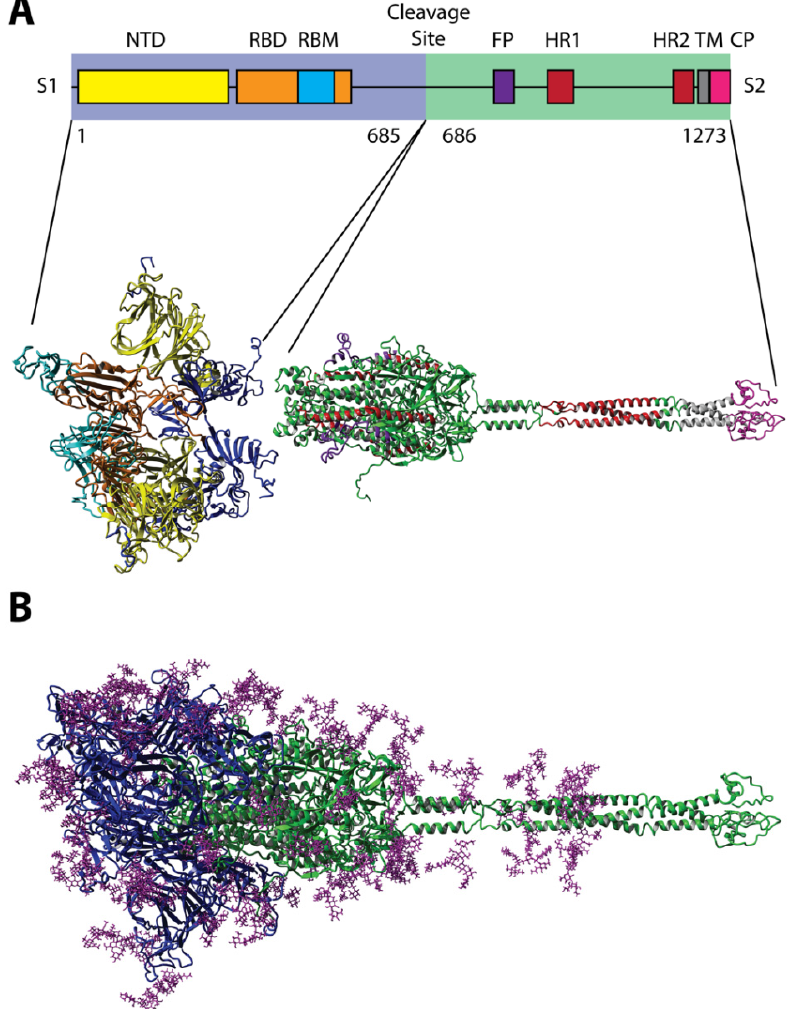
Figure 1. Three-dimensional predicted model of the spike (S) glycoprotein of the SARS-CoV-2 virus composed of ( A ) two well-defined structural domains (S1 and S2), decorated with ( B ) 22 N-glycan residues as modeled using 6VSB and 6VXX [38,39]. Monomers of the S protein, composed of polypeptide chains of 1273 amino acids, form homotrimer spikes on the virus surface [18]. Spike protein monomers are composed of three major structural domains: head, stalk, and cytoplasmic tail. The head comprises the N-terminal domain (NTD; yellow) and the receptor-binding domain (RBD; orange), which displays the receptor-binding motif (RBM; cyan) that is responsible for interaction with cell receptors [40]. RBDs in non-activated viral S glycoprotein trimers are present in a hidden “down” conformation. The S glycoprotein is cleaved by host proteases (trypsin and furin) at the site between the S1 and the S2 subunits [41,42]. The S2 domain of the S protein consists of fusion peptide (FP; purple), two heptad-repeat domains (HR1 and HR2; red), a transmembrane domain (TM; gray), and a cytoplasm domain (CP; pink). A second proteolytic site (S2 ′ site), located within the S2 subdomain, is also cut by type II transmembrane serine protease (TMPRSS2) as well as cathepsin B and L (CatB/L) to enable virus-cell fusion by triggering the dissociation of S1 and the irreversible refolding of S2, a conformational change of the S protein and the fusion of the viral envelope and endosomes [42] .